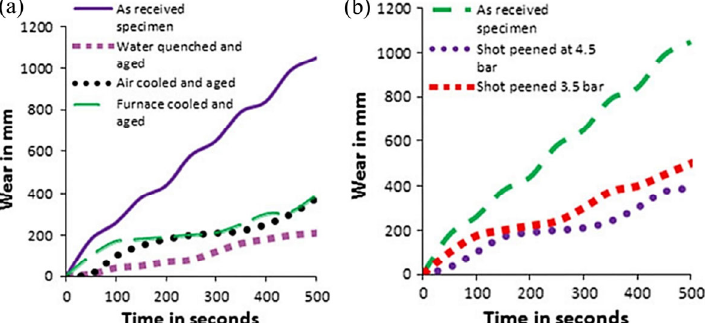
Fig. 19 Wear characteristics of Ti64 in comparison to the processed specimens: (a) heat treated; (b) shot peened. Reproduced with permission from Ref. [3]. Copyright Springer Nature,